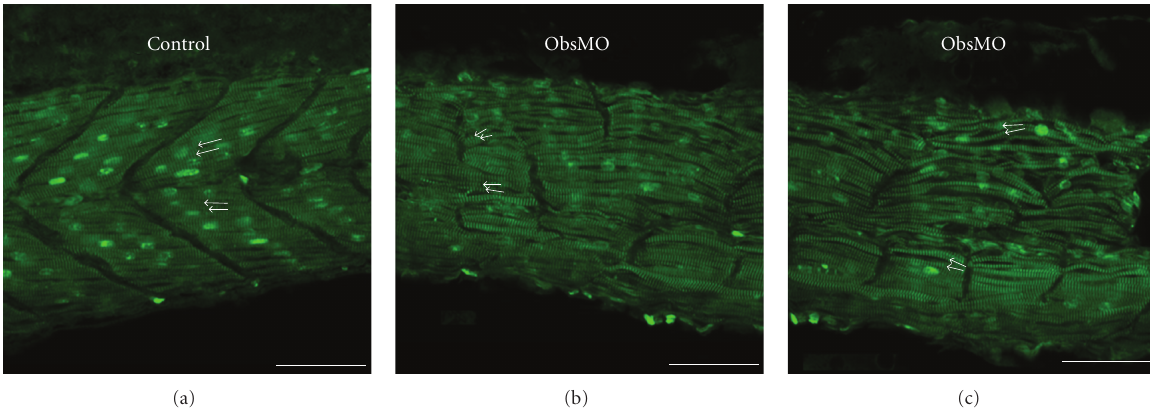
Figure 11: Obscurin depletion results in diminished alignment of myofibrils in adjacent myocytes. (a) At 48hpf, myofibrils in adjacent myocytes are aligned (arrows) along a nearly identical axis of contraction. (b), (c) In obscurin morphant embryos, there is a loss of the precise parallel alignment (arrows) of myofibrils in adjacent myocytes. Scale bars are 50 μ